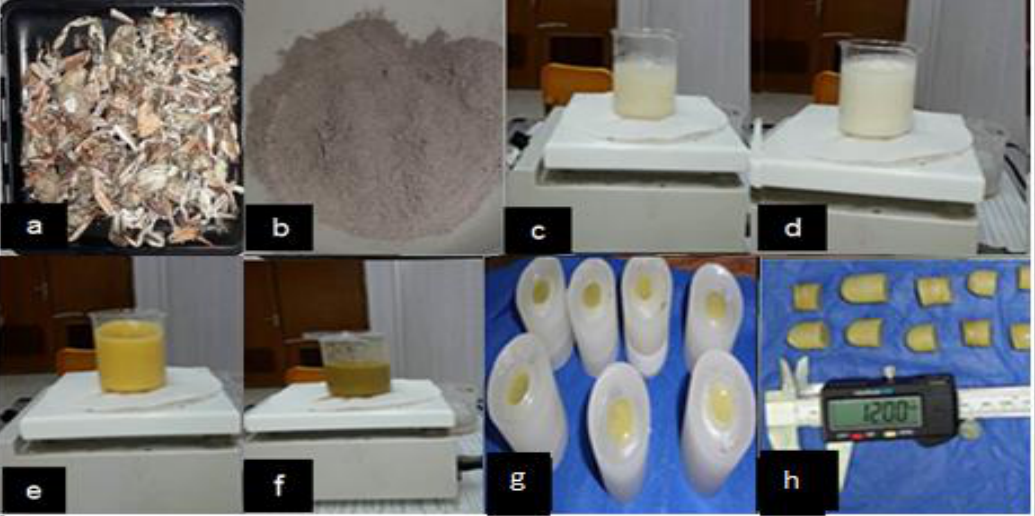
Figure 1. Photograph for preparing scaffold (A) Removed soft tissues. (B) Burn at 600°C. (C) Dissolve gelatinin hot-deionized water. (D) Dissolve dextrin and in cold water and added to gelatin. (E) Al-kharitadded tothe mixture. (F) Crab powderaddedto the mixture. (g) Pour the mixture into a cylindrical wax mold. (h) After removed of wax,measurement and cutting of scaffolds to 1-1.2 cm